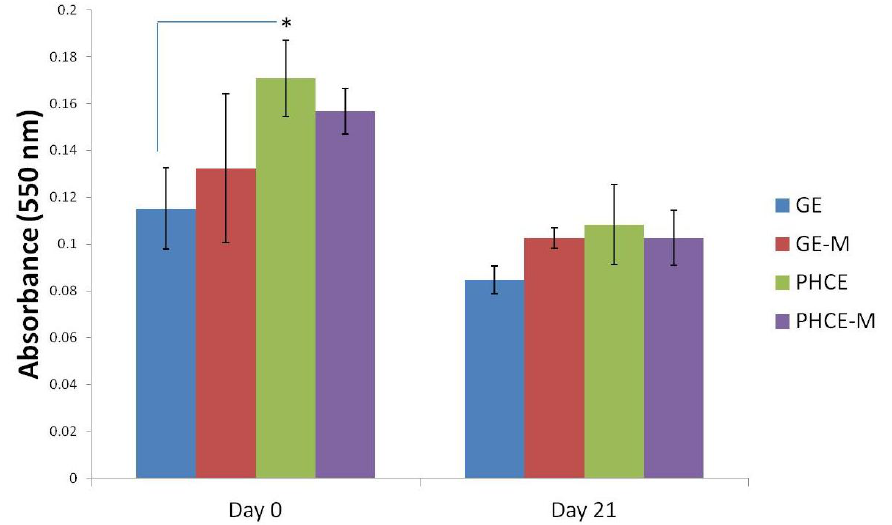
Figure 3. Alizarin Red S (ARS) staining of GE and PHCE scaffolds directly before and after mineralization (Day 0) and of all scaffolds after 21 days incubation in 1× PBS. PHCE sponges reported a significantly higher initial mineral content than control GE